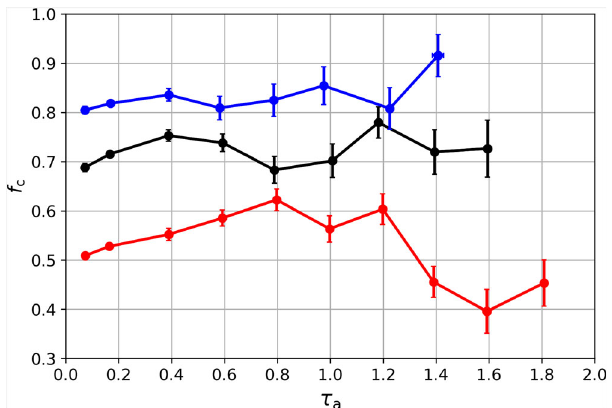
Fig. 3 Updraft velocity at cloud base ( w ), from 2000 to 2014, as a function of the columnar aerosol optical depth ( τ a ), according to classes of atmospheric preconditioning. Red, black, and blue coloring, error bars, and τ a as in Fig. 1. Updraft velocity at cloud base 41 estimated from ECMWF Era-Interim 39 surface reanalysis data at the fi ve sites used in this study at 18:00 UTC (14:00